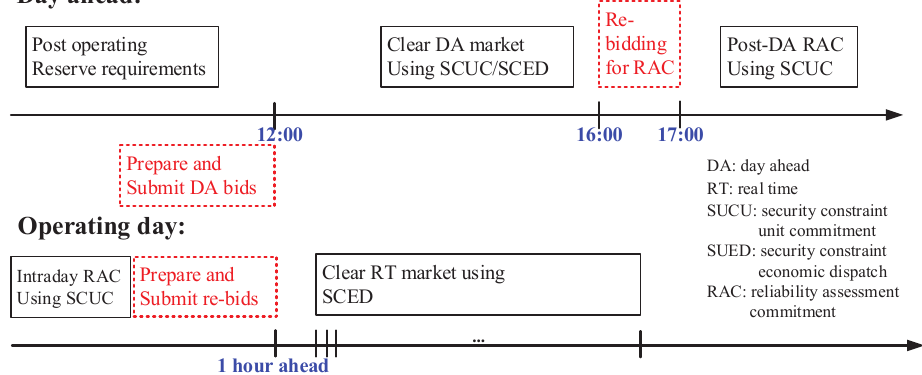
Figure 5. Market operation